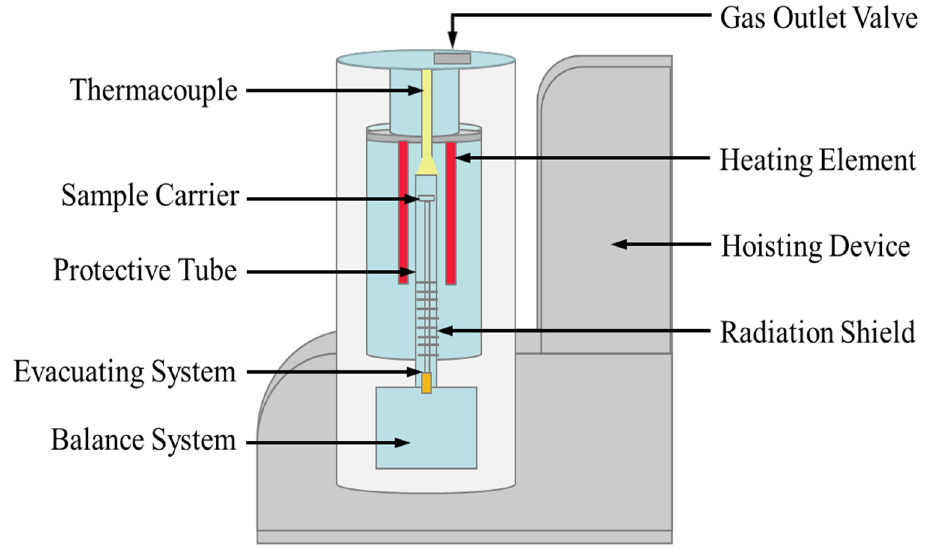
Figure 2. Schematic of the thermogravimetric analyzer for thermal stability